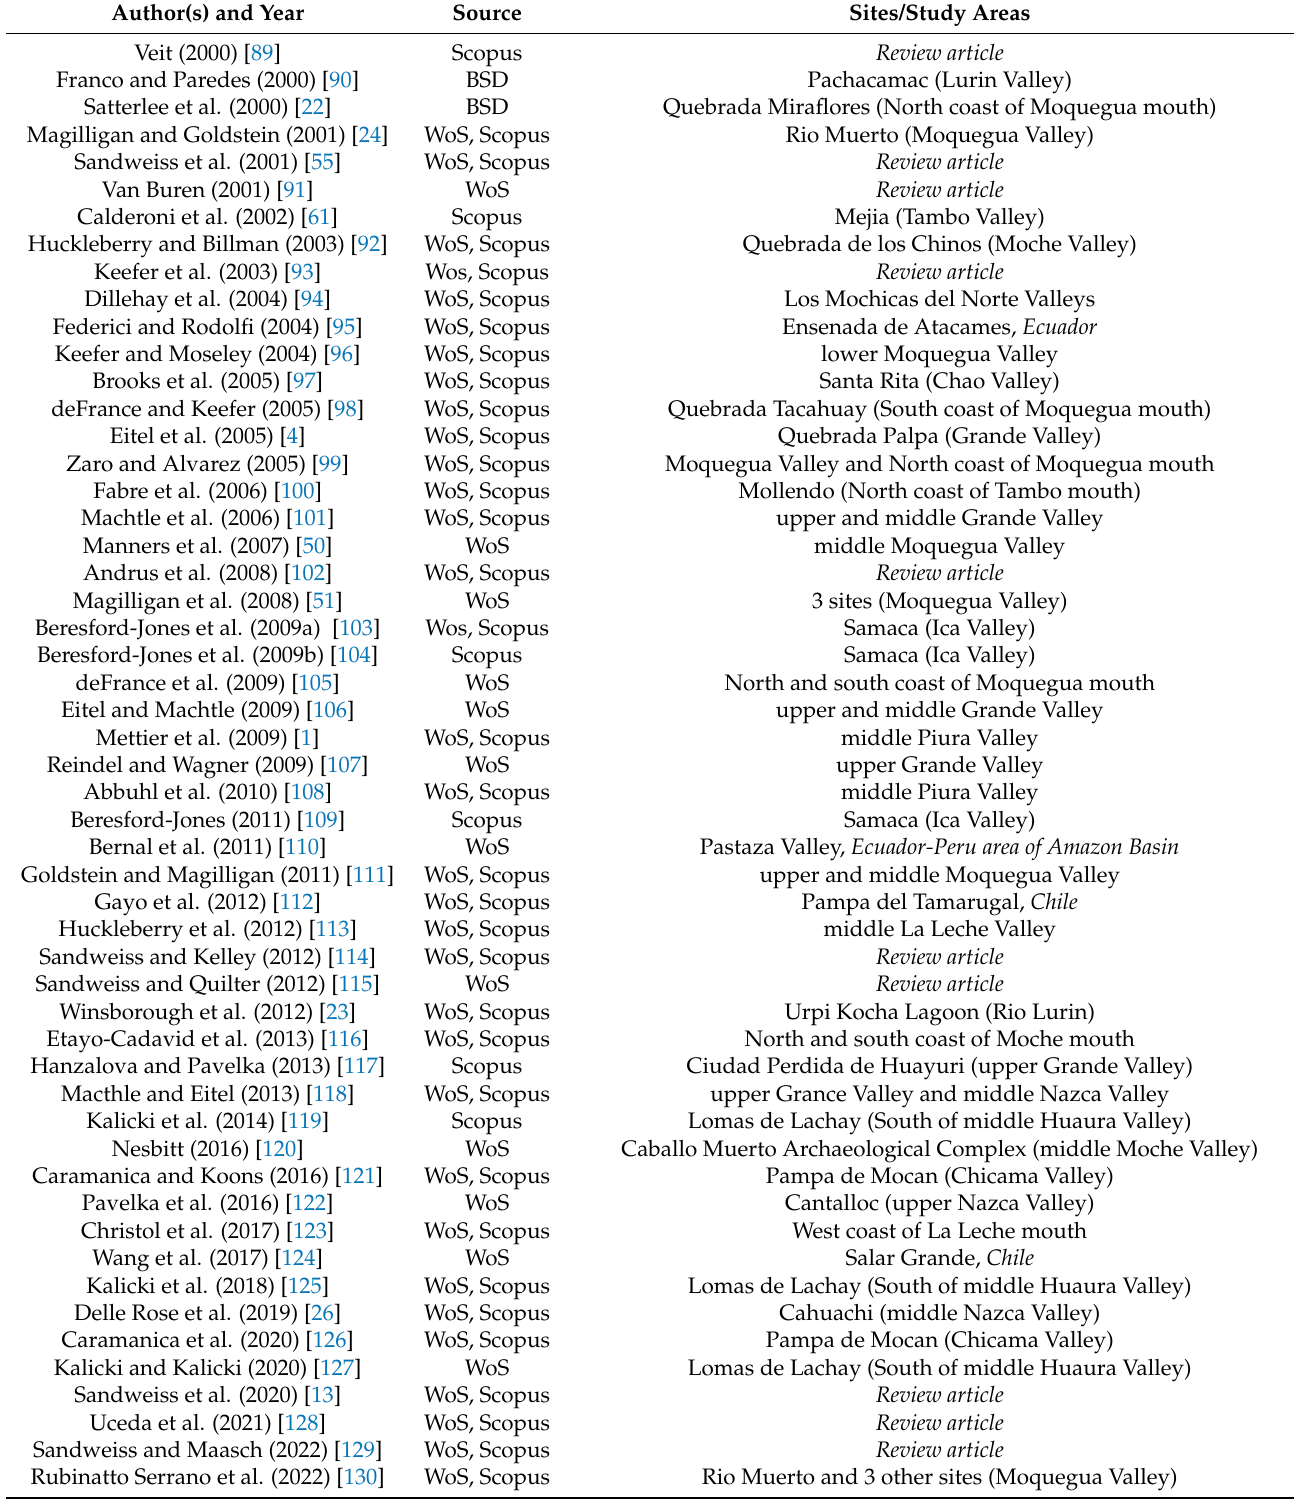
Table 4. Summary of reviewed works. This table continues from Table